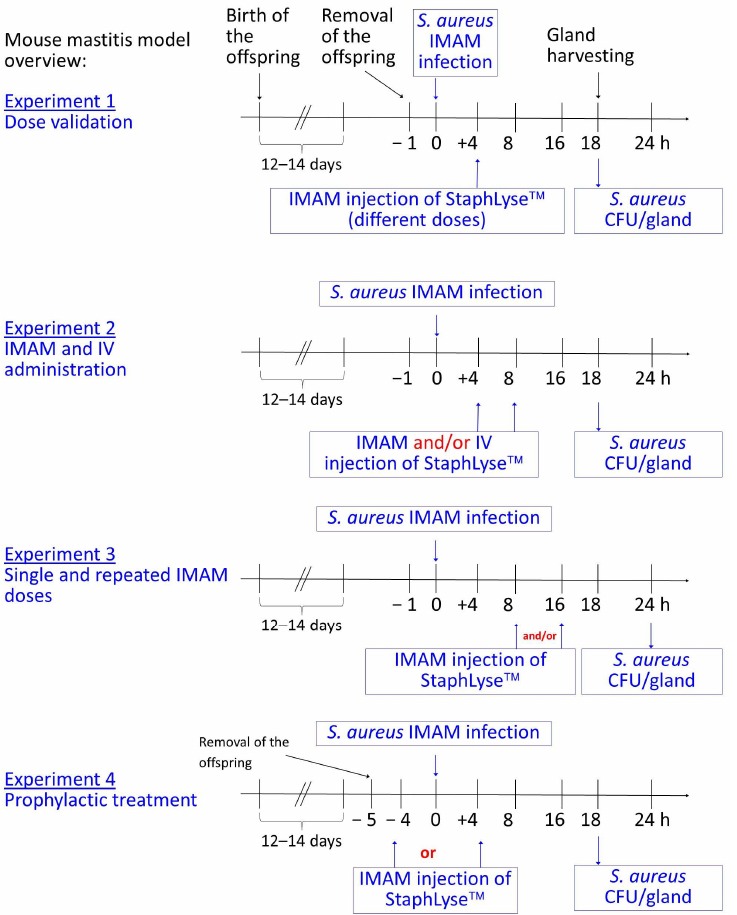
Figure 2. General outline of the mouse mastitis model and experimental designs. Four